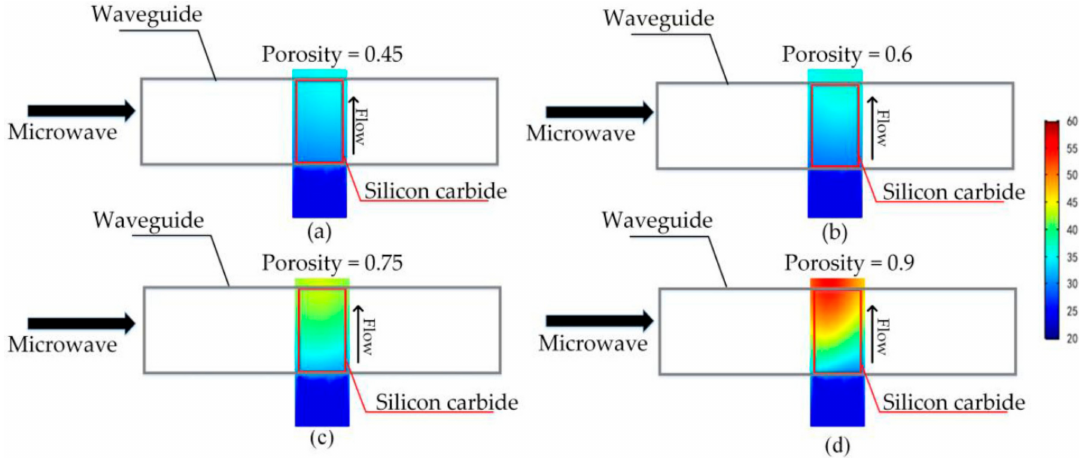
Figure 11. Temperature rise ( ◦ C) comparisons at different porosities in simulation. ( a ) temperature rise at porosity of 0.45; ( b ) temperature rise at porosity of 0.6; ( c ) temperature rise at porosity of 0.75; ( d ) temperature rise at porosity of